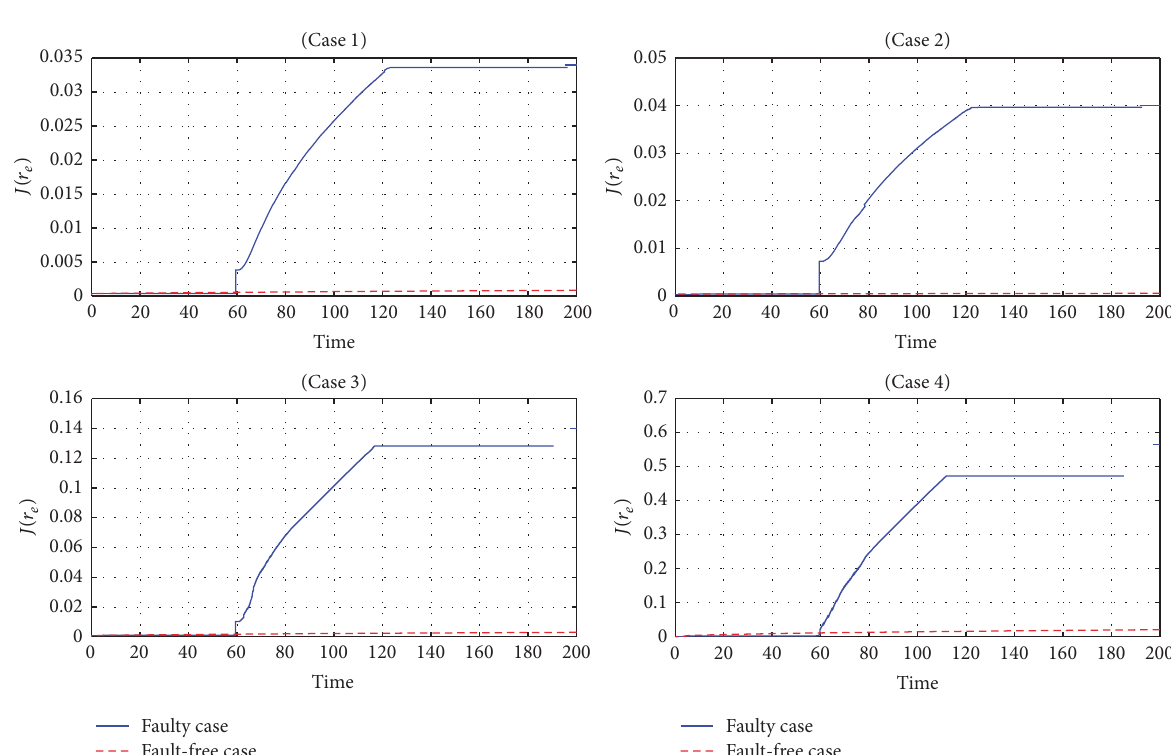
Figure 3: Evolution of 𝐽(𝑟 𝑒 ) in Example